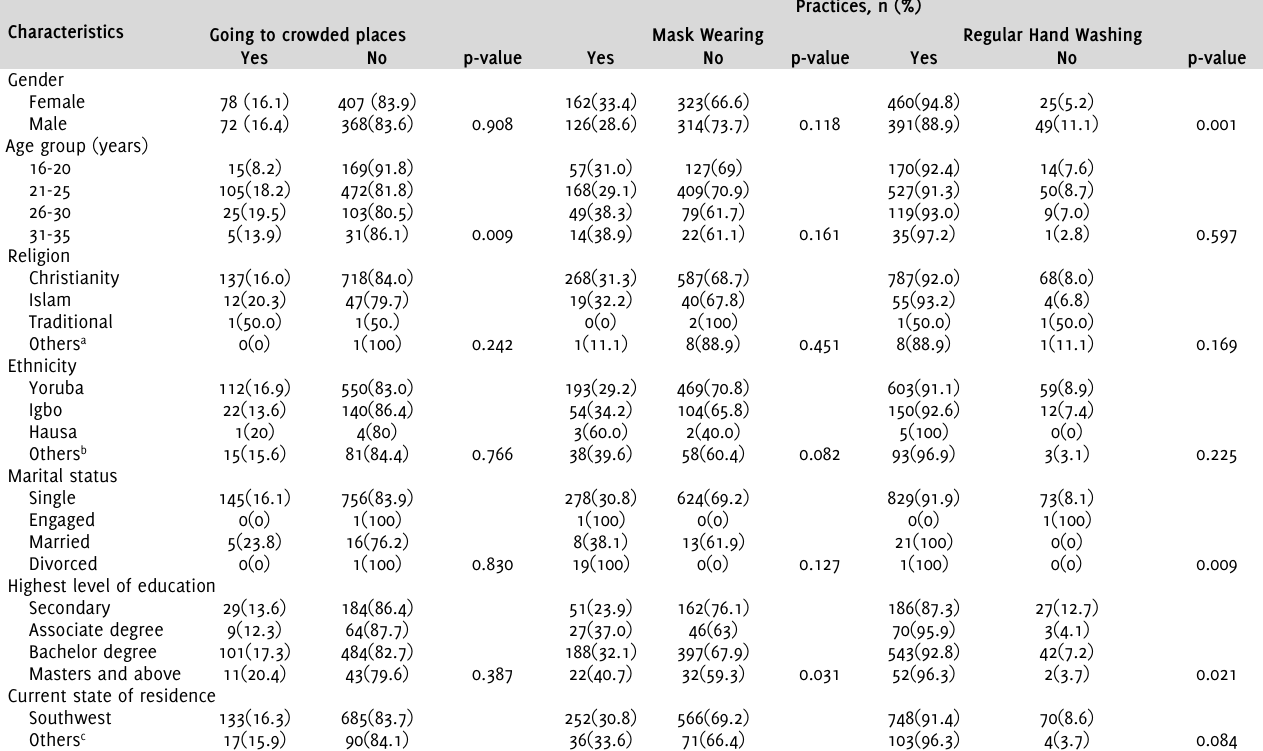
Table 4 . Practices Towards COVID-19 by Demographic